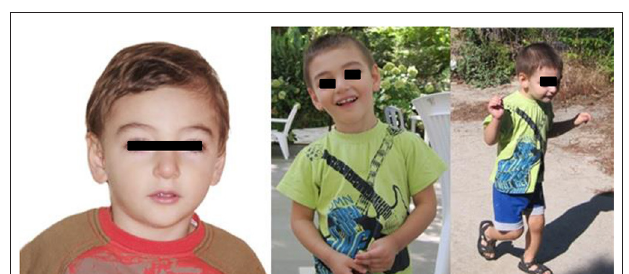
FIGURE 2 | Two years old.